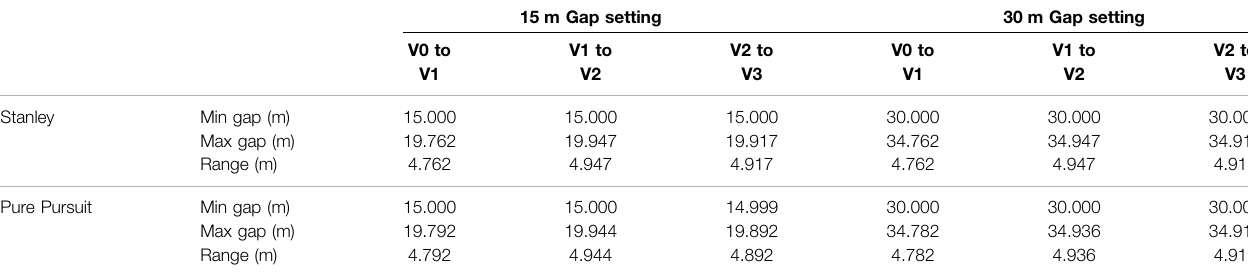
TABLE 4 | Gap range for different gap settings.